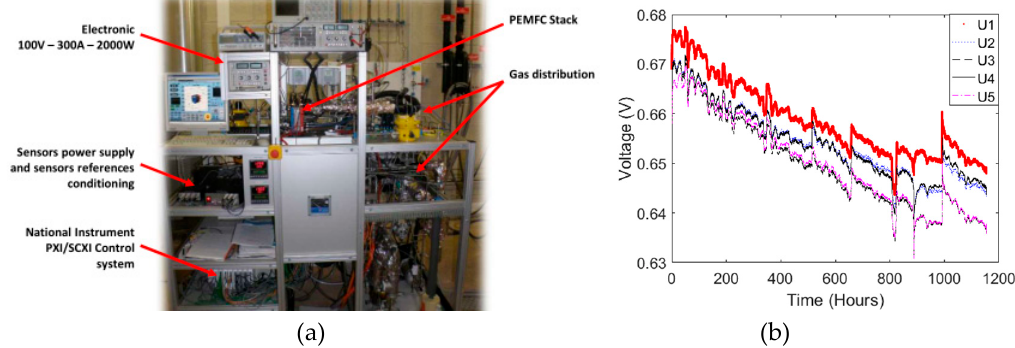
Table 1. Proton exchange membrane fuel (PEMFC) operating parameters.